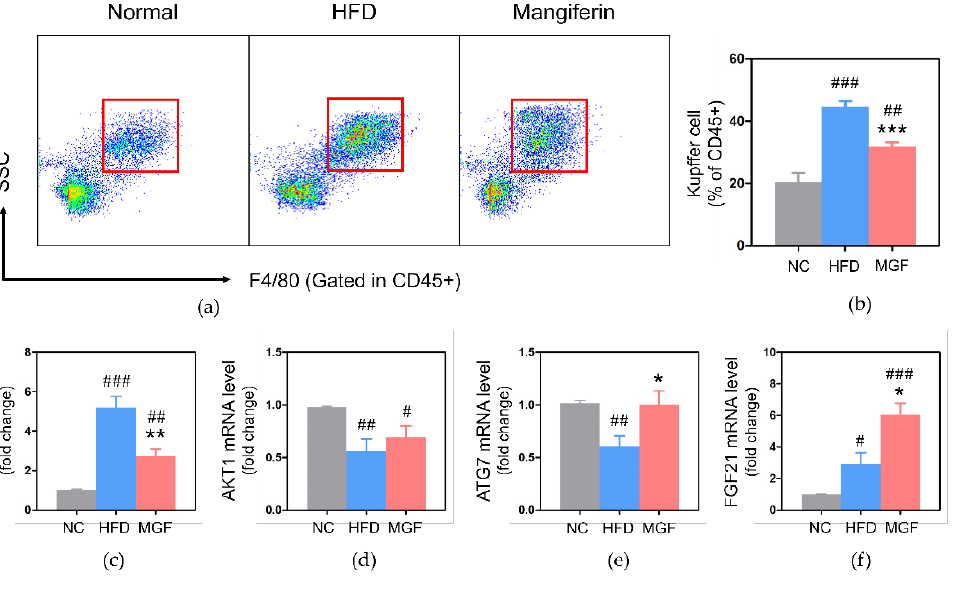
Figure 7. Analysis of KCs and gene expression of the mRNA level in liver tissue. ( a ) Flow cytometry of total KCs. ( b ) Percentage of total KCs. Expressions of ( c ) NF- κ B, ( d ) AKT, ( e ) ATG7, and ( f ) FGF21. Data are expressed as mean ± standard error of mean. # p < 0.05, ## p < 0.01, and ### p < 0.001 indicate the results of comparison with the NC group, and * p < 0.05 and ** p < 0.01, *** p < 0.001 indicate the results of comparison with the HFD group. NC, normal chow; HFD, high-fat diet; MGF, HFD + MGF 150 mg/kg/day; MGF, mangiferin; KCs, Kupffer cells; NF- κ B, nuclear factor kappa B; ATG7, autoph- agy-related gene 7; FGF21, fibroblast growth factor 21.